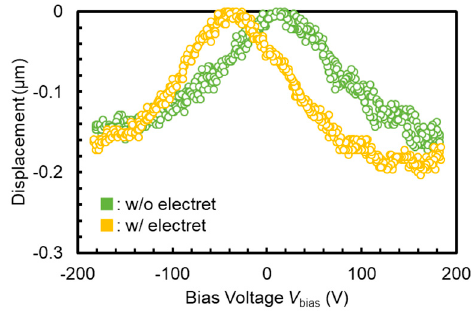
Figure 10. Voltage-displacement characteristics of out-of-plane φ = 1.5 mm membrane actuator before and after electret fabrication.